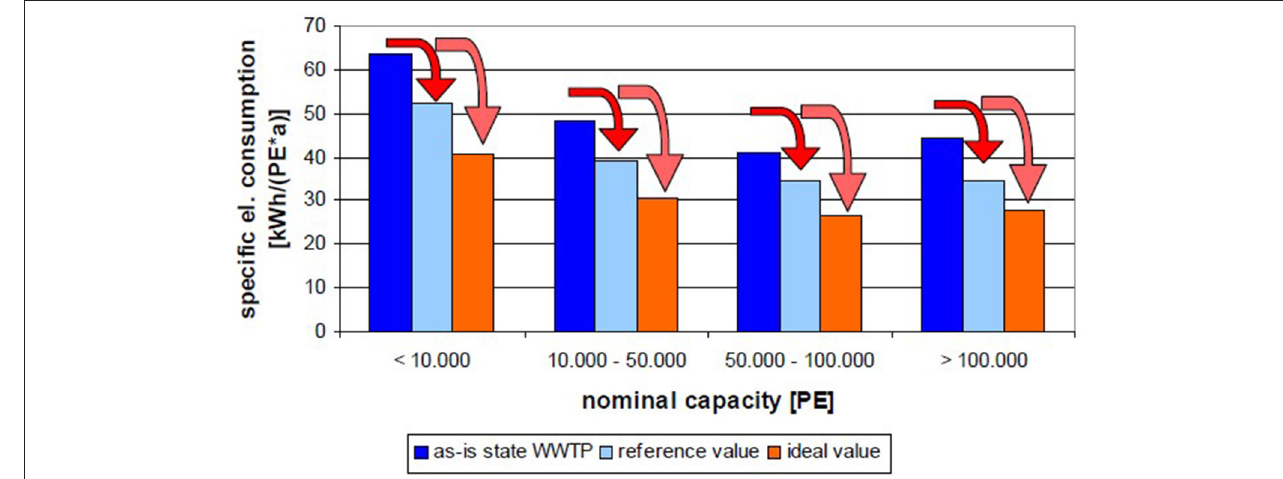
FIGURE 4 | Average results of all executed studies from the work of Husmann (2009).